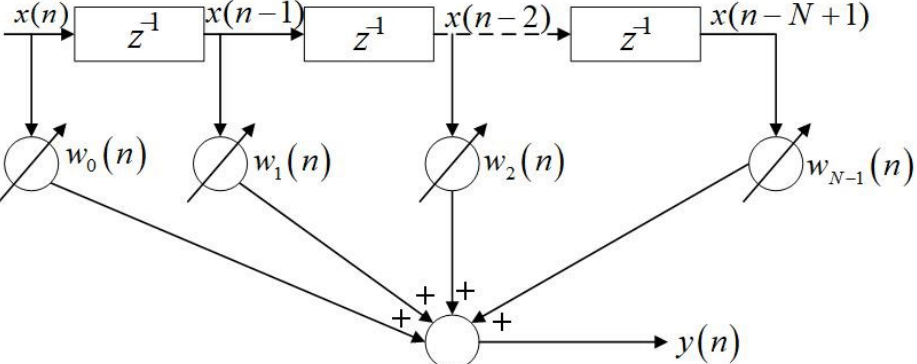
Figure 3. Adaptive